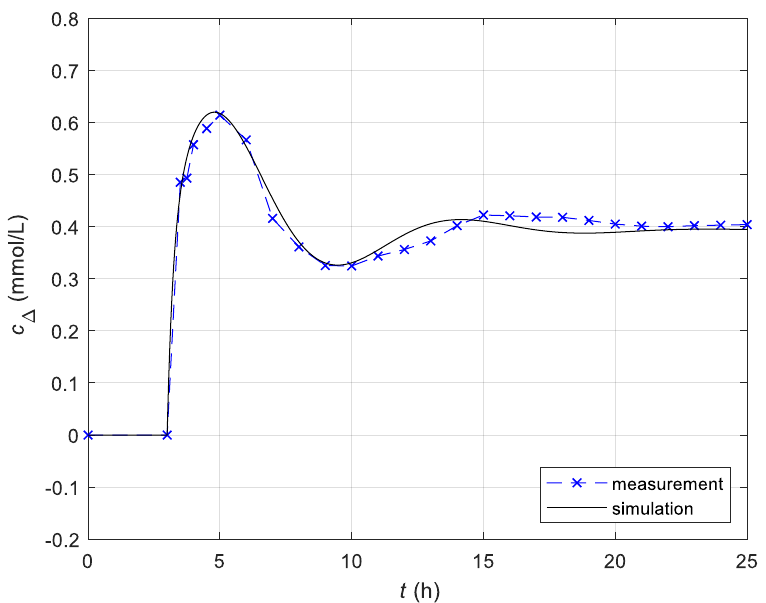
Figure 4. Time courses of deviations of dissolved CO 2 concentrations c ∆ due to temperature change obtained by measurements in laboratory bioreactor and simulation with the identified temperature-dependent model.